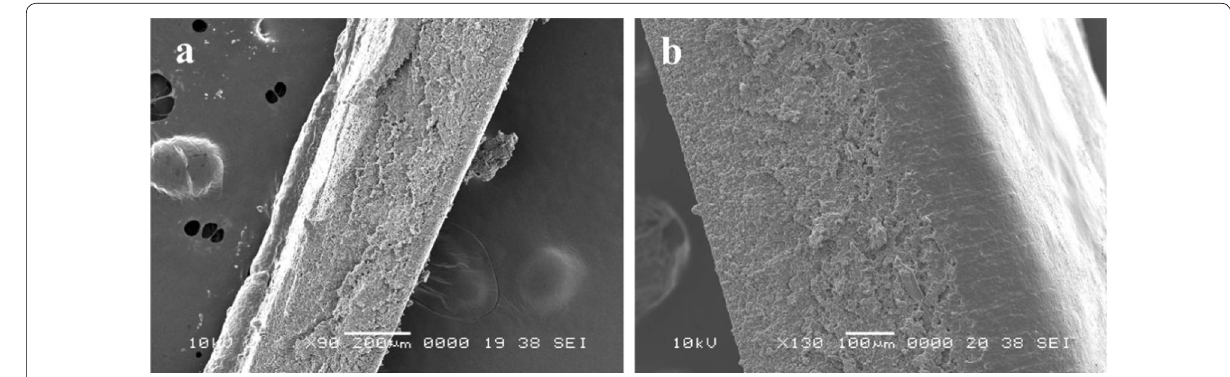
Fig. 6 Measuring thickness using SEM image of cross sections Thickness of each cell-plastic is evaluated using SEM image of cross section. a Cell-plastic (Gly) and b cell-plastic (Gly-BSA) under magnifications of